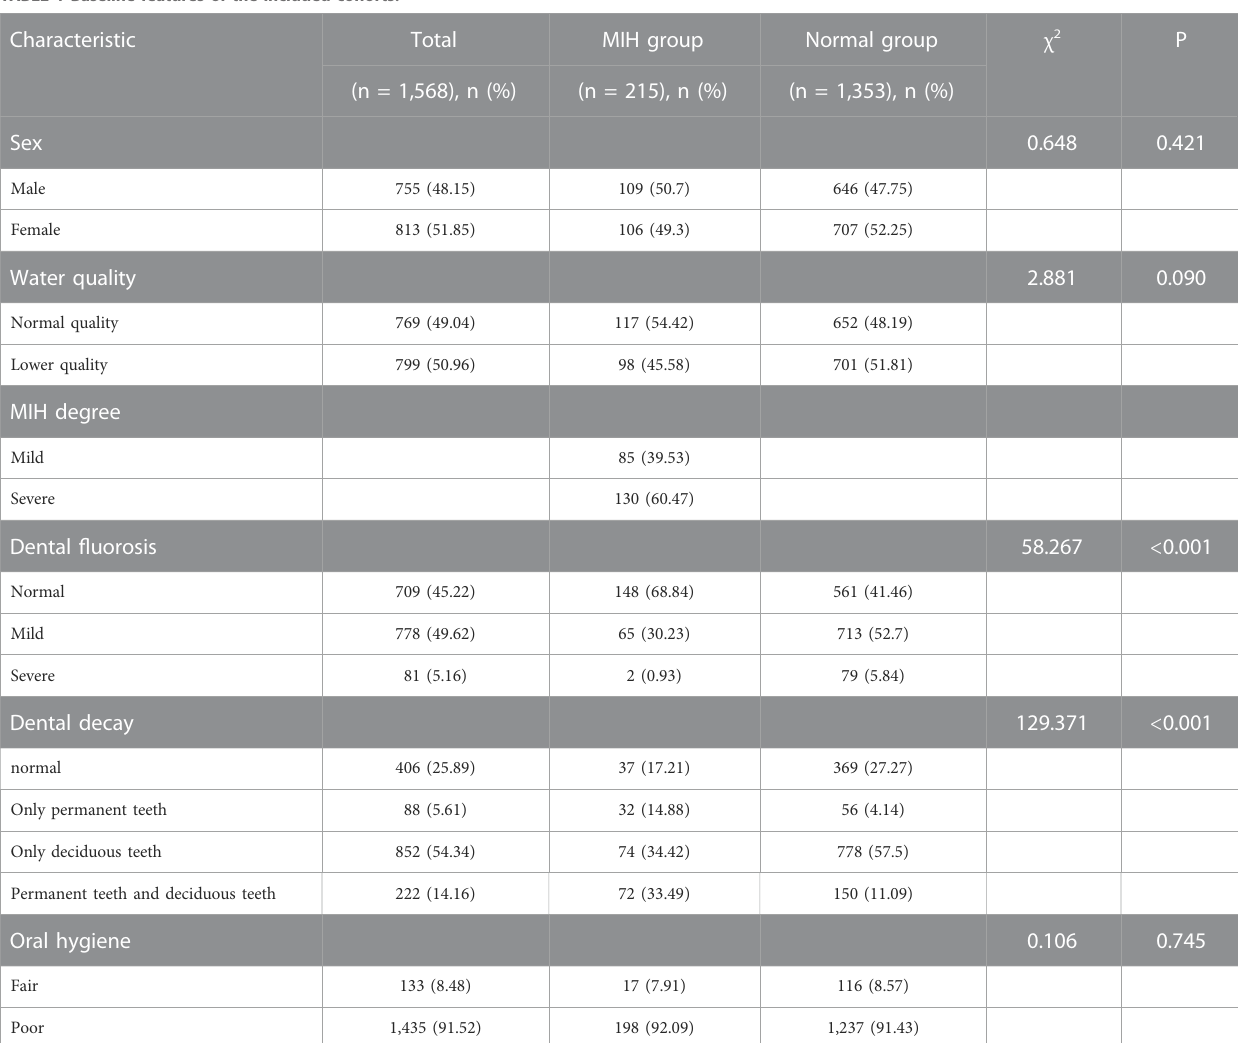
TABLE 1 Baseline features of the included